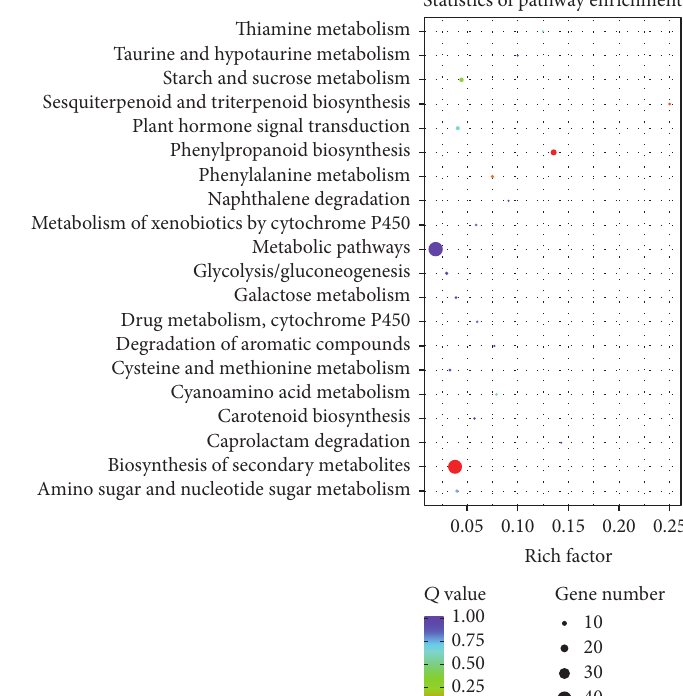
Figure 4: Scatterplot of differentially expressed genes enriched in the top 20 KEGG pathways. Rich factor represents the ratio of the number of DEGs and the number of all unigenes in the pathway; 𝑄 value represents corrected 𝑃 value.